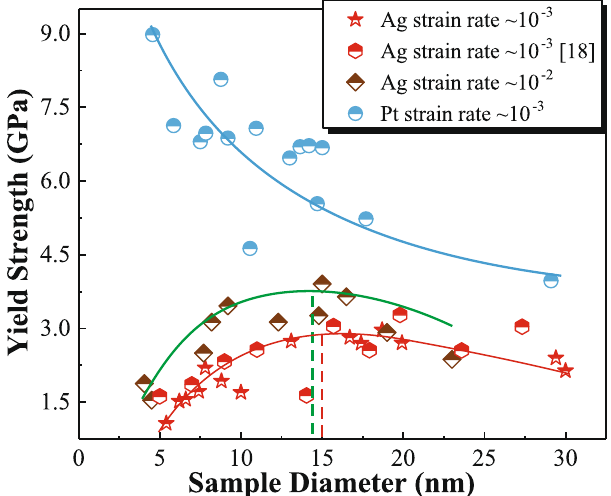
Fig. 1 Size dependence of yield strength in Ag NWs and Pt NWs. In situ tensile straining of < 112 > -oriented Ag NWs with different sample diameters were performed at strain rates of ~ 10 − 2 s − 1 (green points) and ~ 10 − 3 s − 1 (red points). Pt NWs were loaded along <112 > -orientation at a strain rate of ~ 10 − 3 (blue points). The blue, red and green lines represent the tendency of the strength-size relationship in Pt NWs under a strain rate of ~ 10 − 3 s − 1 and Ag NWs under a strain rate of ~ 10 − 2 s − 1 and ~ 10 − 3 s − 1 ,